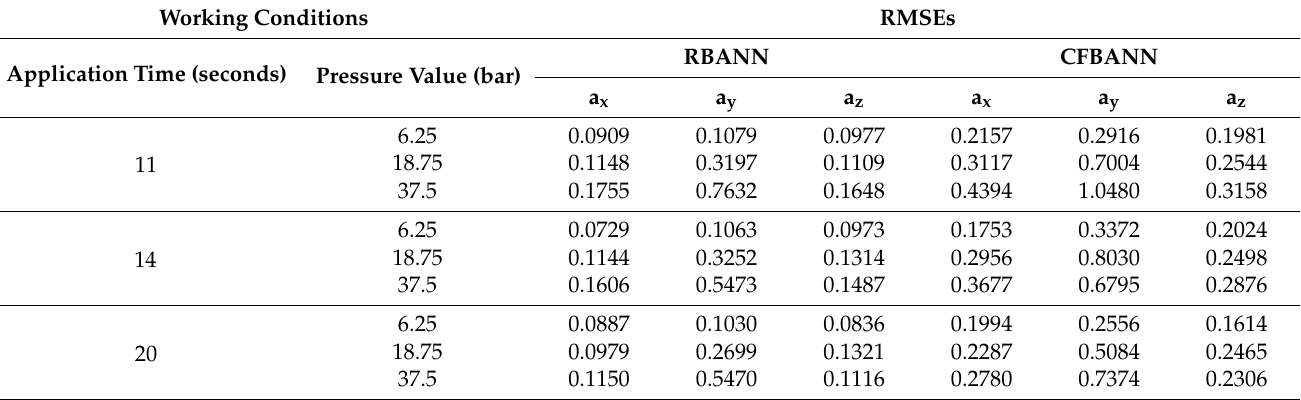
Table 4. Experimental working conditions and RMSE values obtained in the x , y , and z axes.